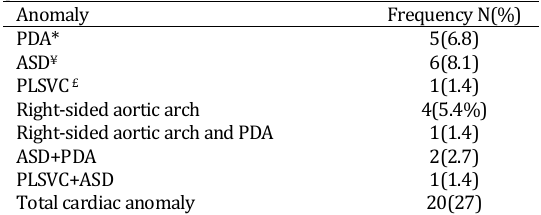
Table 3. Associated cardiac anomalies in tetralogy of Fallot